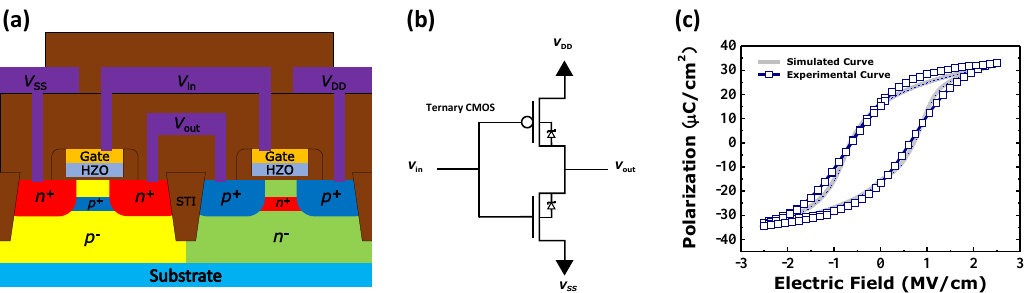
Figure 1. (a) The schematic diagram of TCMOS consisting of ferroelectric-gate field effect transistors (FE-TCMOS). The ferroelectric layer is inserted between gate and oxide interfacial layer. (b) The circuit schematic diagram of FE-TCMOS. Tunnel junction diode is located under the drain-side channel. (c) Experimental polarization-electric field (P-E) curve and calibrated P-E curve by technology computer-aided design (TCAD) simulation.